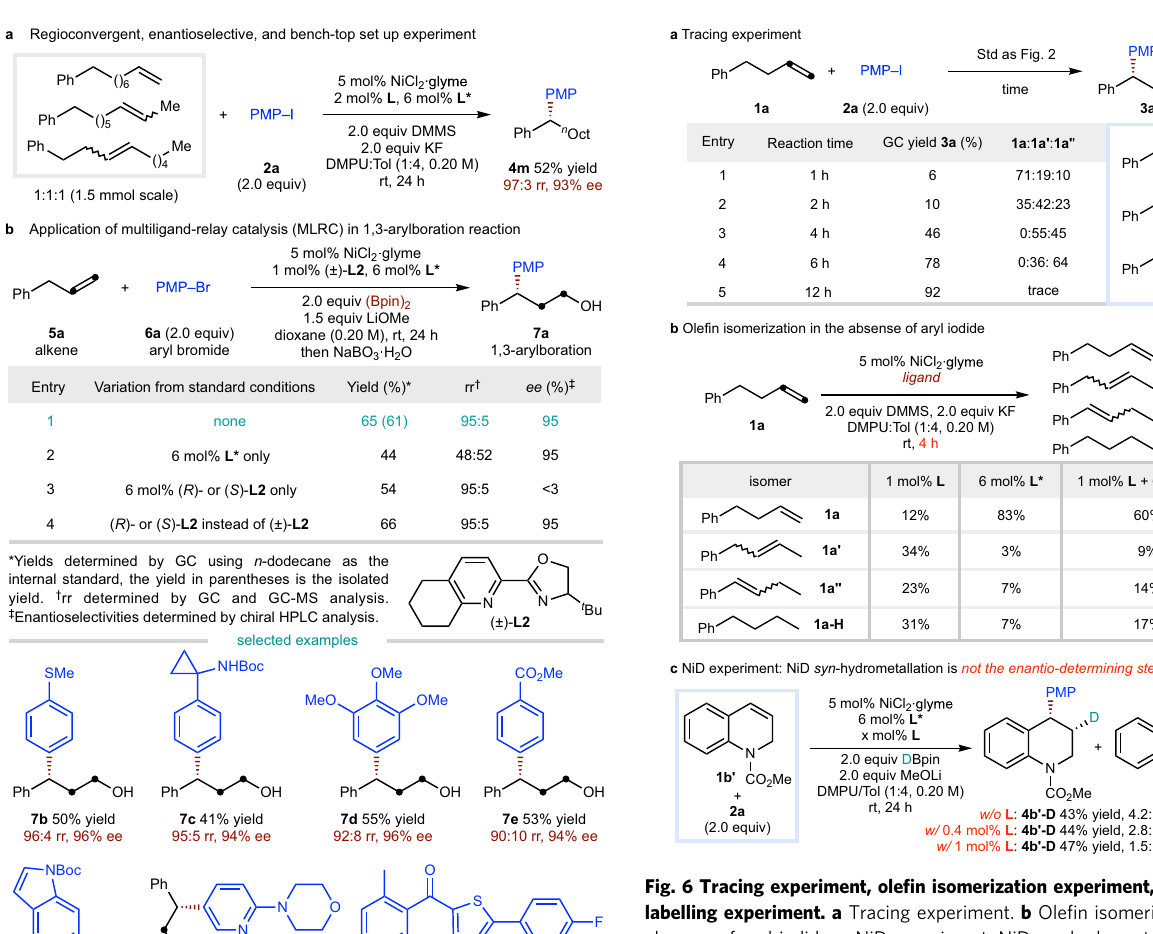
Fig. 6 Tracing experiment, ole fi n isomerization experiment, and isotopic labelling experiment. a Tracing experiment. b Ole fi n isomerization in the absence of aryl iodide. c NiD experiment: NiD syn -hydrometallation is not the enantio-determining